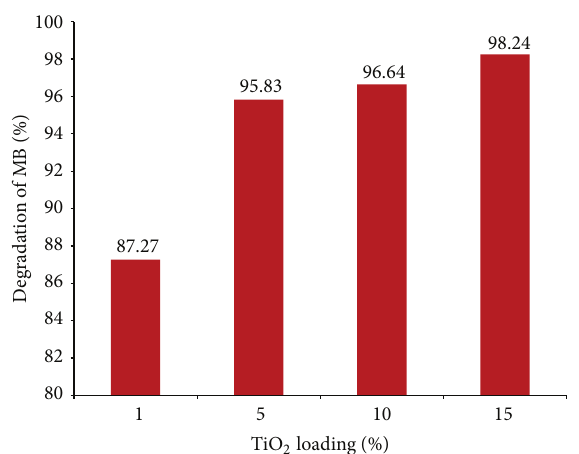
Figure 6: Effect of TiO 2 loading (%) on degradation of MB (under 90 minutes of UV light irradiation in room temperature).